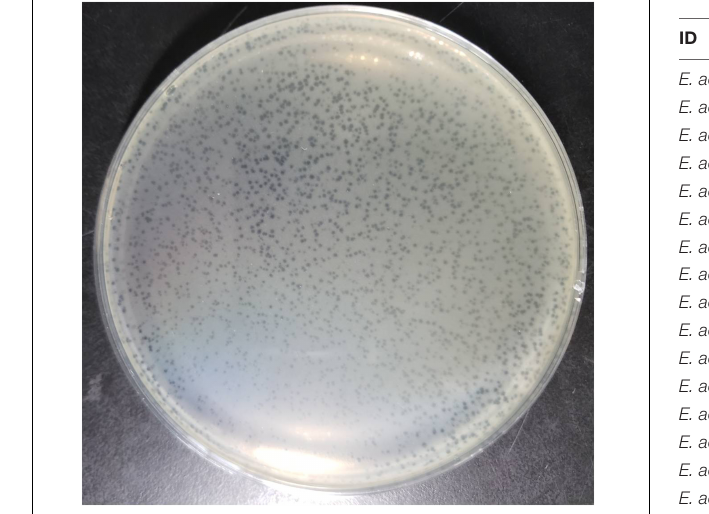
TABLE 1 | Host spectrum of vB_EaeM_ ϕ